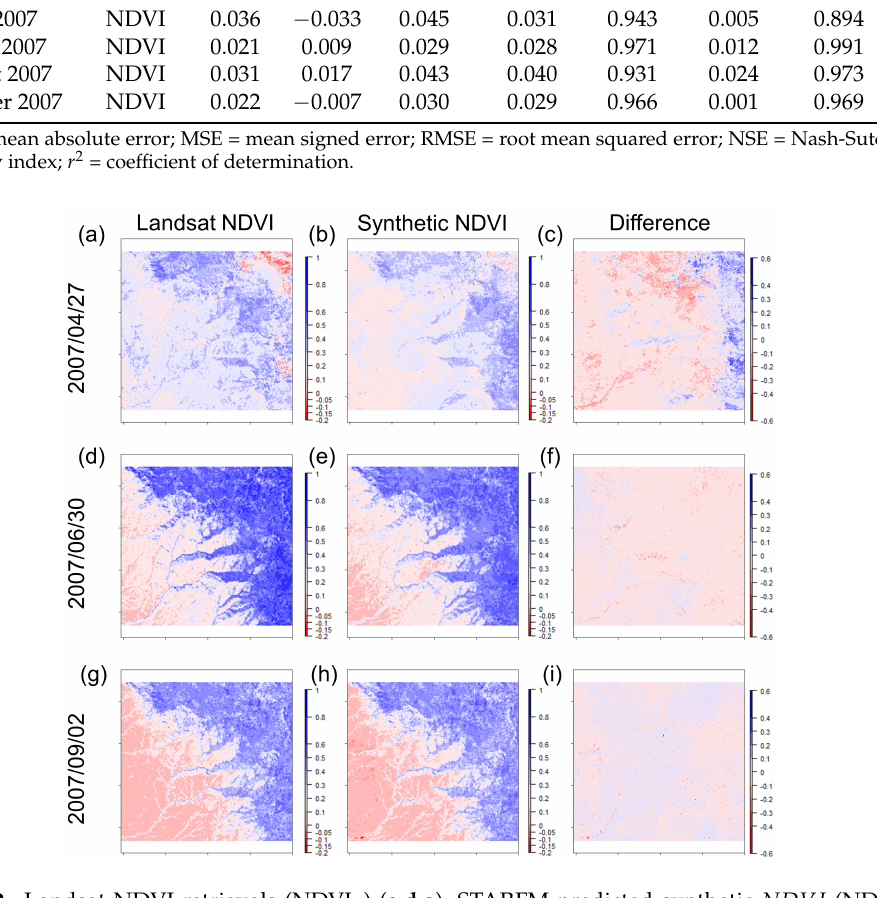
Figure 2. Landsat NDVI retrievals (NDVI L ) ( a , d , g ), STARFM-predicted synthetic NDVI (NDVI S ) ( b , e , h ), and the differenced errors (NDVI L − NDVI S ) ( c , f , i ) for three dates throughout the 2007 growing season. Images cover the full extent of Dry Creek Experimental Watershed (DCEW), Idaho, USA. Table 3. Error and correlation statistics for full scene difference of observed and predicted Normalized Difference Vegetation Index (NDVI) values. The STARFM-predicted synthetic image was created using one pair of training